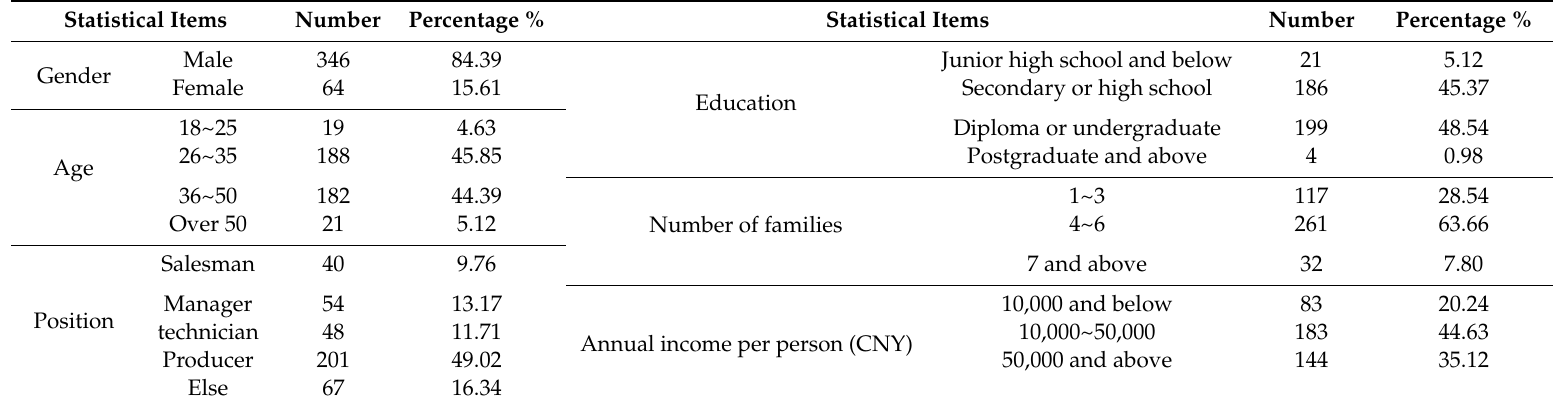
Table 2. Descriptive statistics of relocated employees of chemical enterprises in the Yangtze River Basin.